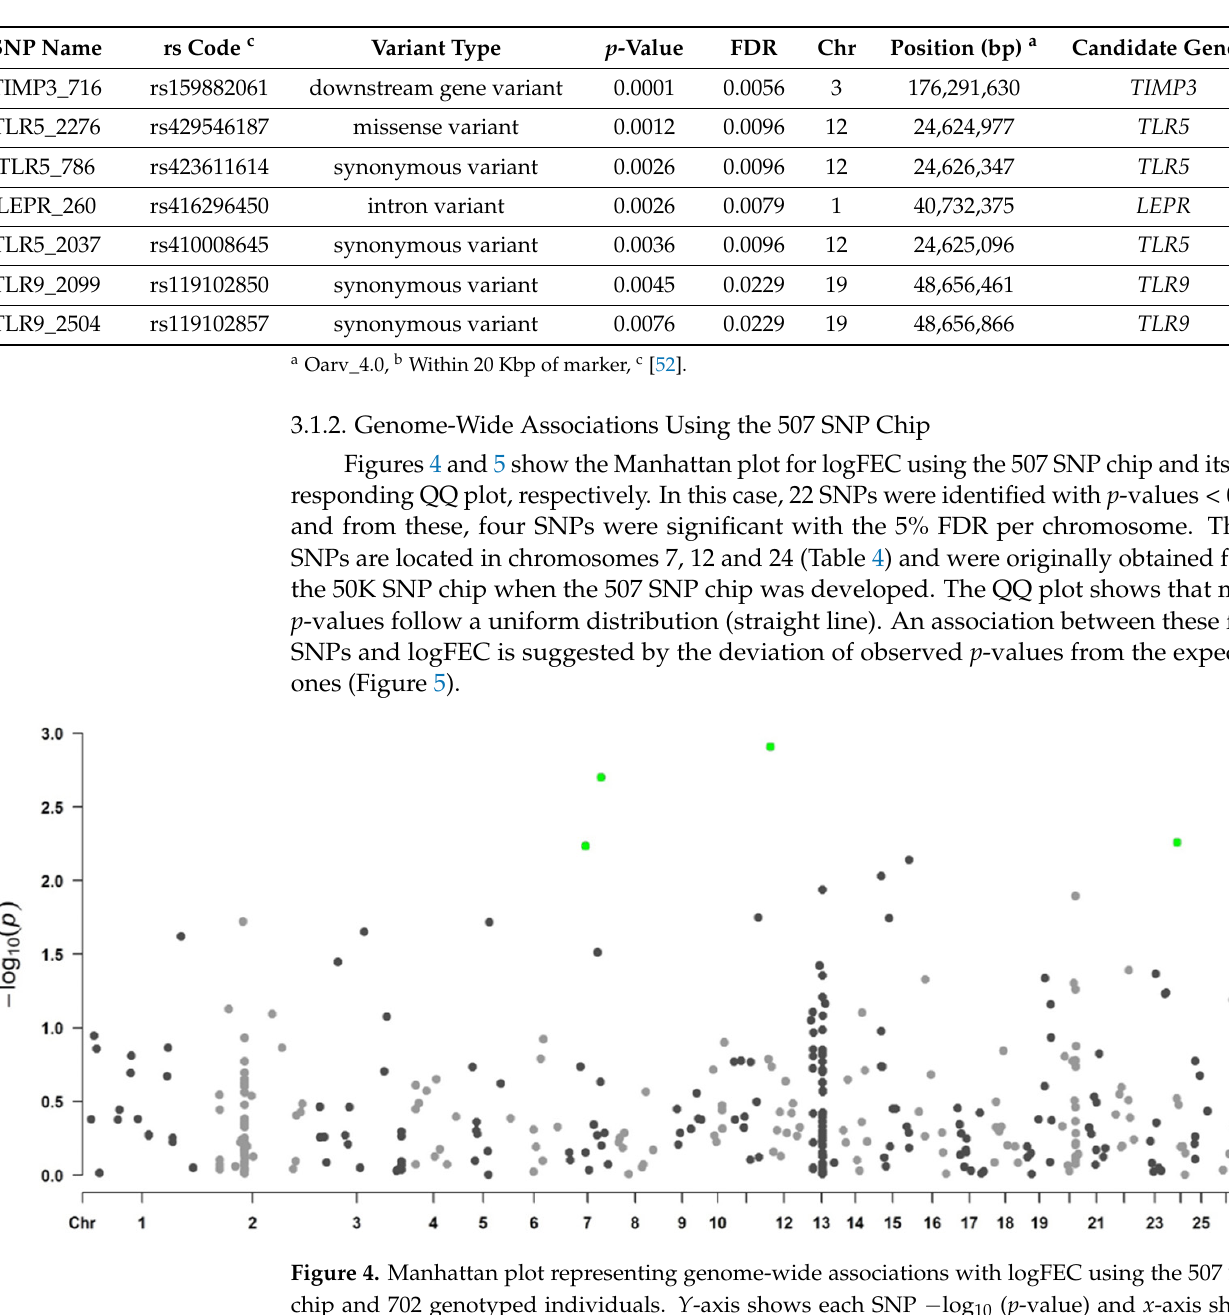
Table 3. Significant SNPs identified with GWAS for logFEC using 170 SNPs with a chromosome-wise FDR of 5%.